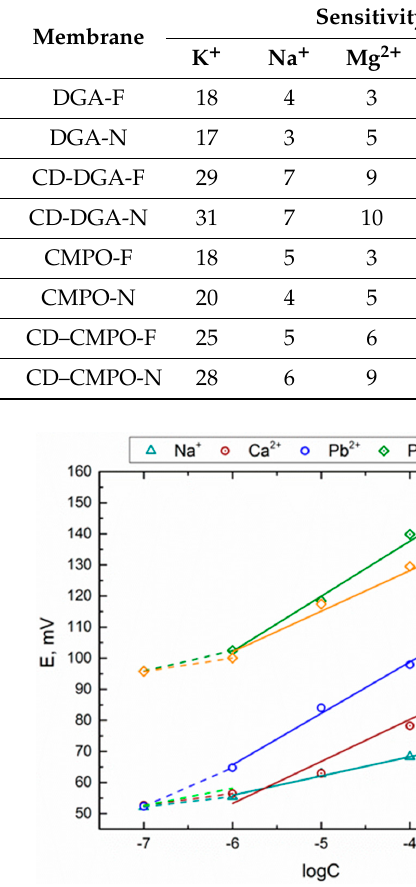
Figure 2. Typical calibration curves shown for the CD-CMPO-N sensor.